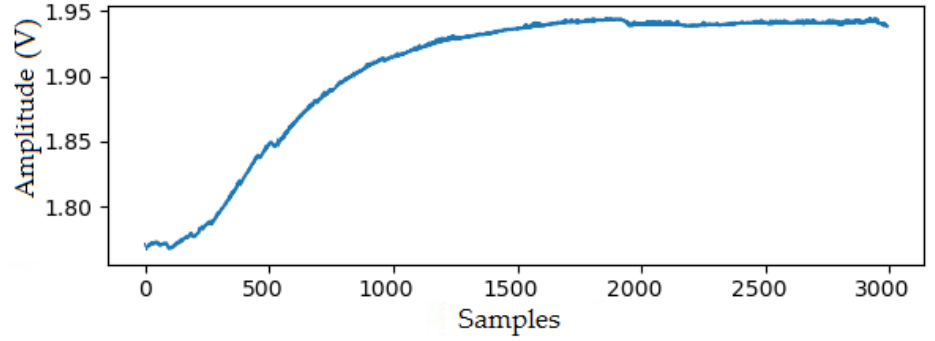
Figure 9. Galvanic Skin Response (GSR) signal from a participant in a relaxed state.